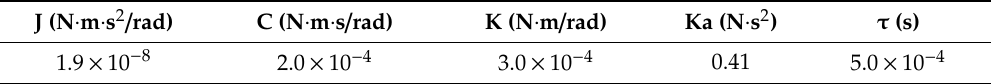
Table 6. Identified mechanism parameters of the tested accelerometer.